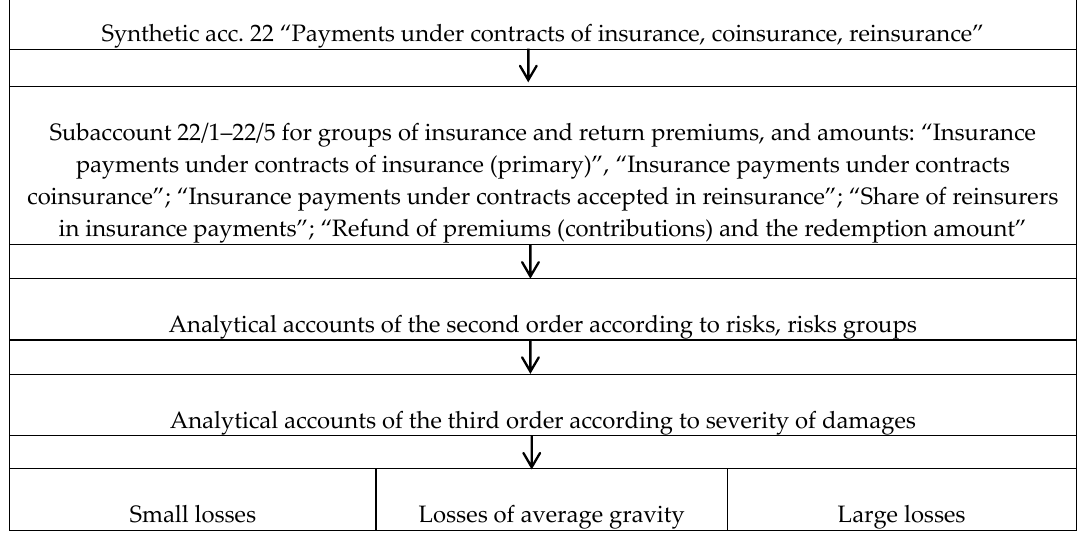
Figure 4. The scheme of constructing a multi-stage hierarchical structure of analytical accounting of payments in insurance companies, given the severity of the loss of the source (compiled by the authors).